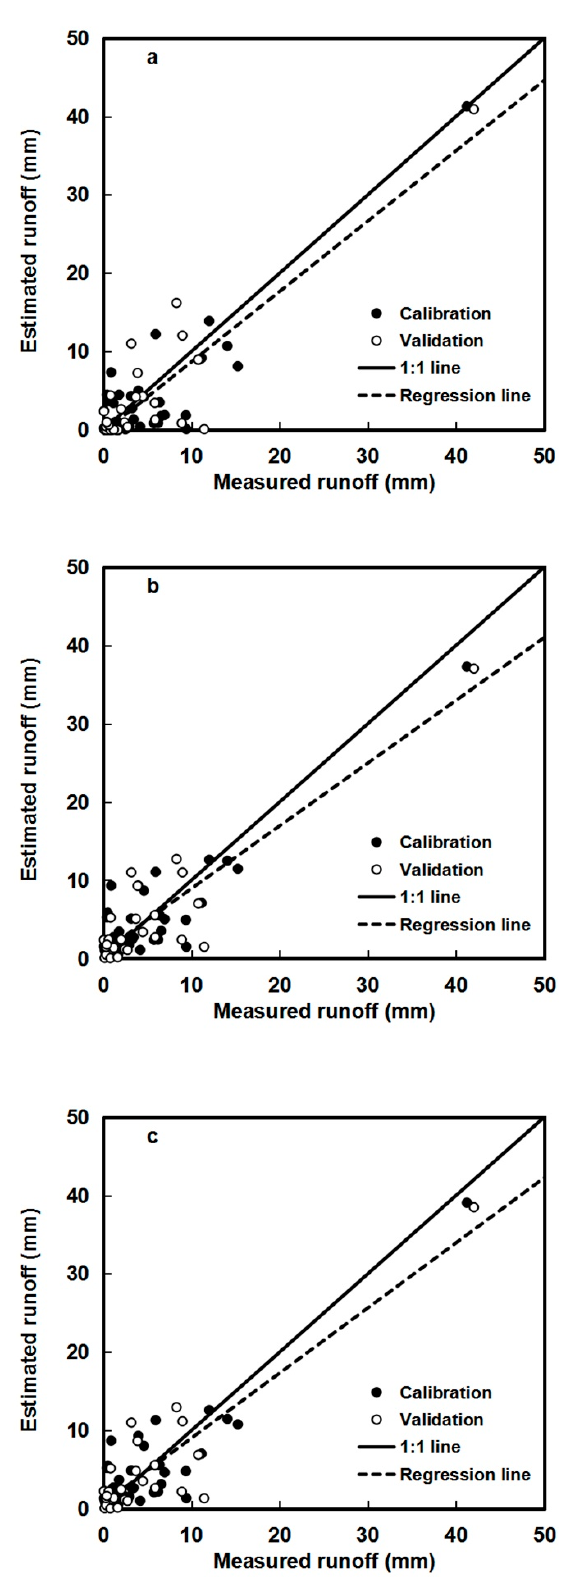
Figure 5. Measured versus estimated runoff depths for ( a ) Method 1, ( b ) Method 2, and ( c ) Method 3 for calibration and validation for three runoff plots of the XDG watersheds.